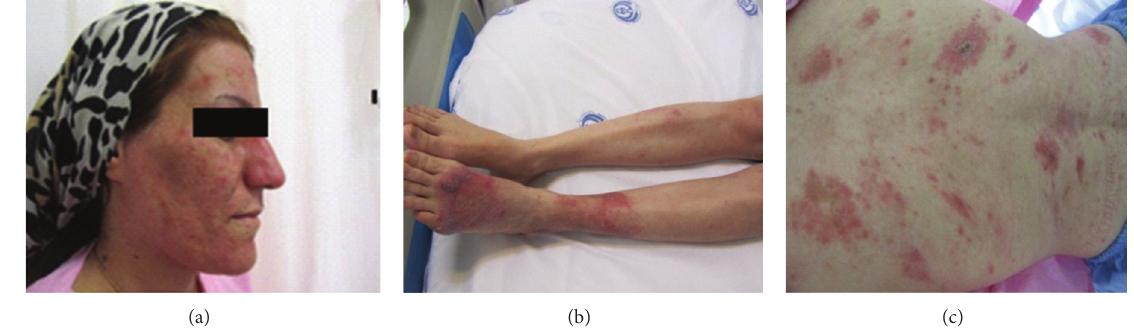
Figure 1: The patient’s skin lesions (a) on face, (b) on lower extremity, and (c) on